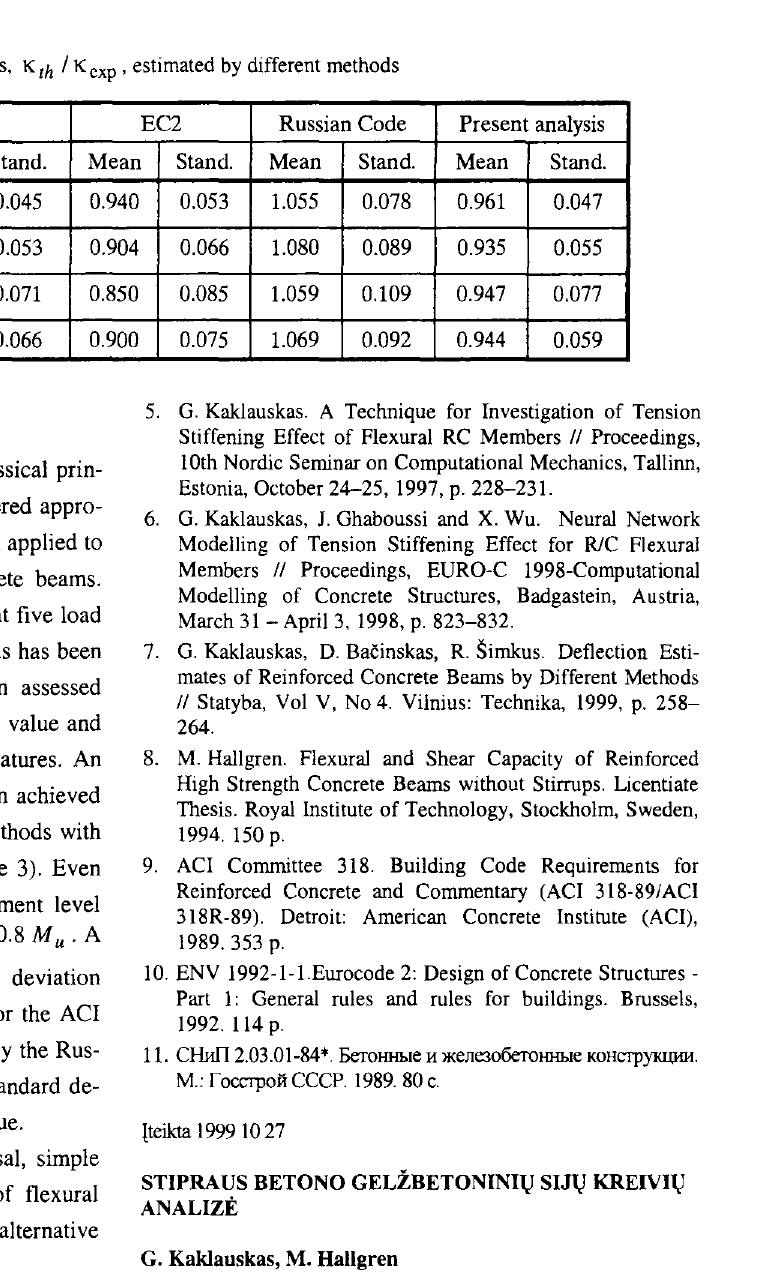
Table 3. Statistical parameters for relative curvatures, Krh I Kcxp, estimated by different methods No. Characteristics of ACI EC2 Russian Code Present analysis data Mean Stand. Mean Stand. Mean Stand. Mean